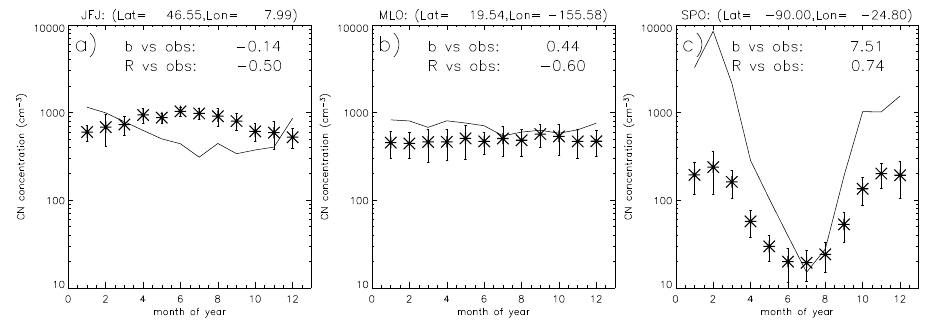
Fig. 18. Simulated monthly-mean CN concentrations (solid lines) compared to observations (asterisks) at GAW monitoring sites classified as free troposphere. Sites are (a) Jungfraujoch, (b) Mauna Loa and (c) South Pole. Values of b and R are shown for each site. Error bars show the standard deviation for each month over the range of years shown in Table 7. Model values are taken from the level that best matches the height above sea-level for the station.